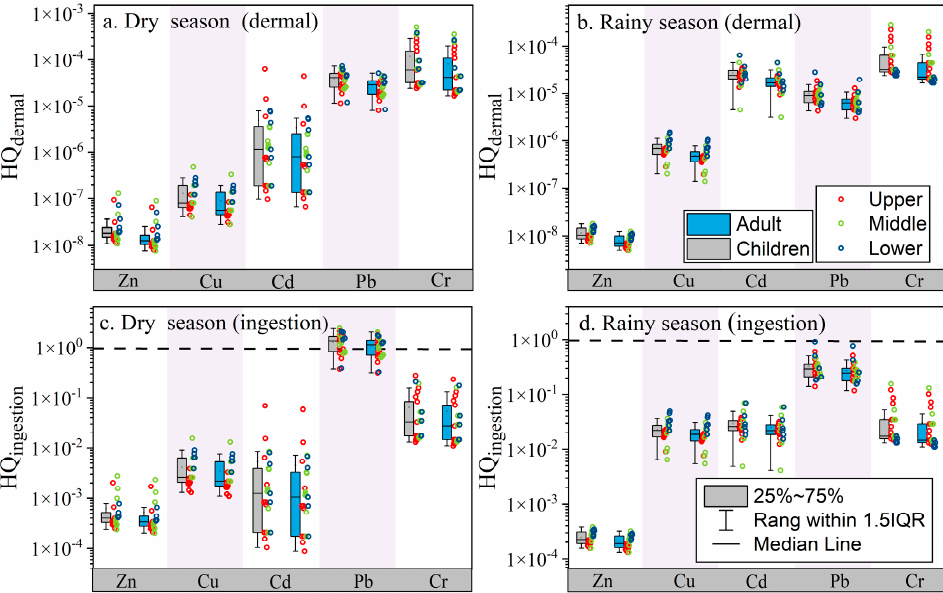
Figure 5. Non-carcinogenic risks of Zn, Cu, Cd, Pb, and Cr for children and adults in the Fuhe River watershed, China. watershed,